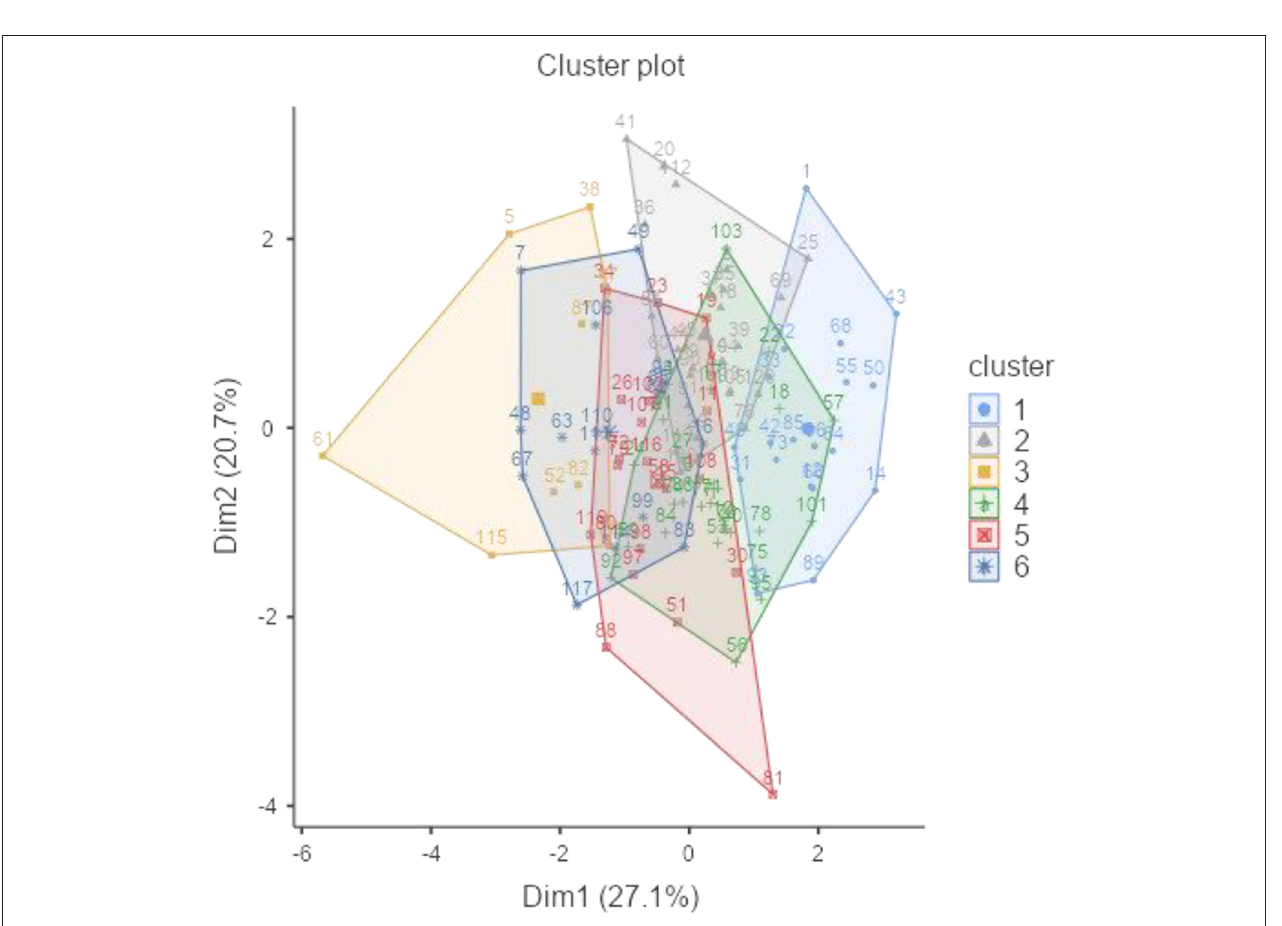
FIGURE 2 | Cluster plot of 120 cowpea accessions based on their biochemical traits.